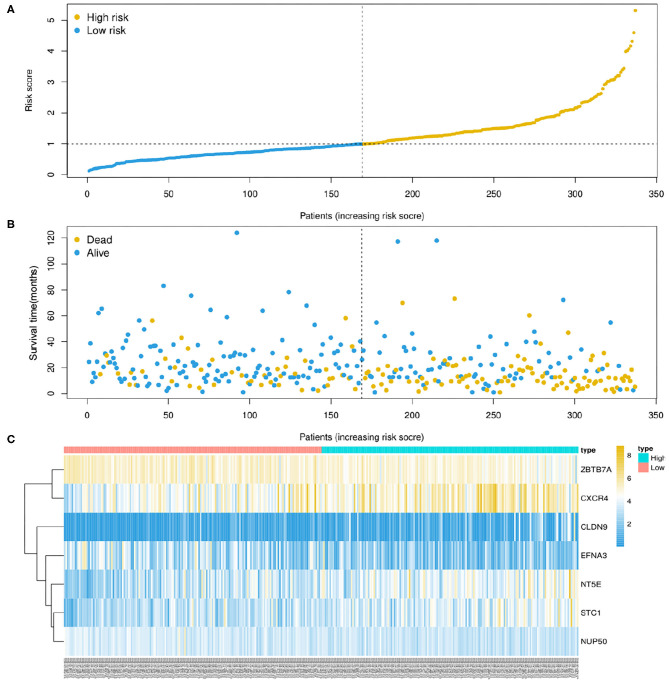
Risk score analyses of GC patients in the training cohort based on the seven-GRGs signature. (A) Distribution of risk scores per patient. (B) Relationships between survival status and survival times of GC patients ranked by risk score. The black dotted line represents the optimum cut-off point dividing patients into low- and high-risk groups. (C) Heatmap of the seven-GRG expression profile. Colors from yellow to blue indicate decreasing expression level from high to low.